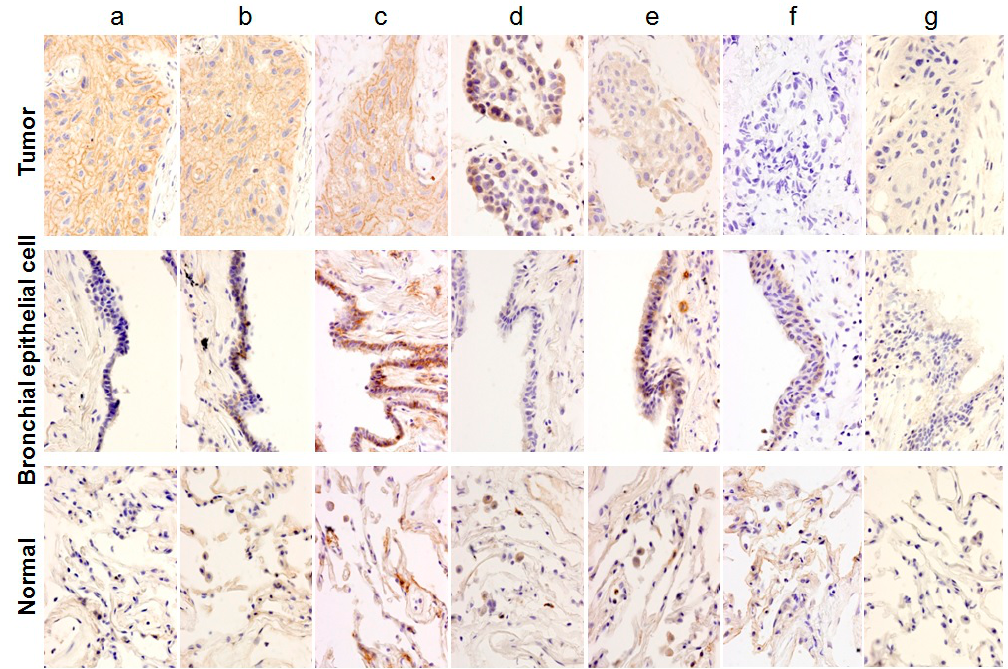
Figure 1. Classification of histochemical analysis. The patterns obtained by the histochemical analysis were classified into 7 categories: ( a – g ) The staining patterns of three portions, namely tumor cells, bronchial epithelial cells, and normal pulmonary alveolus cells and interalveolar septum, were compared. The details of classification are described in the text.